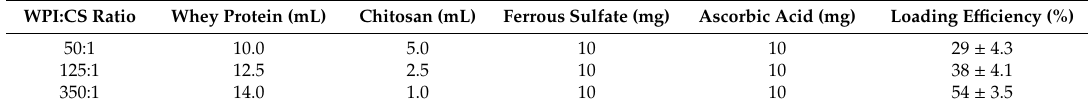
Table 3. Composition of iron loaded WPI-CS nanoparticle